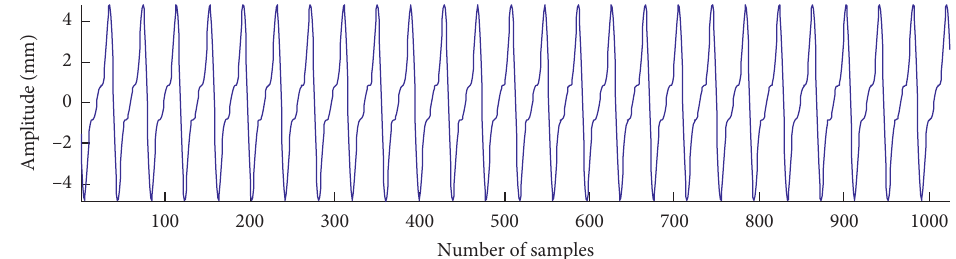
Figure 4: The signal processed by the improved method.